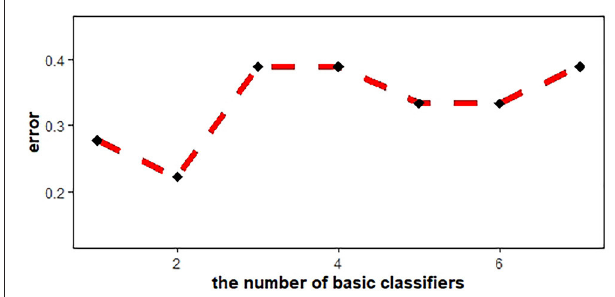
FIGURE 2 | AdaBoost error line chart. When the number of basic classifiers was 2, the error reached the minimum value.